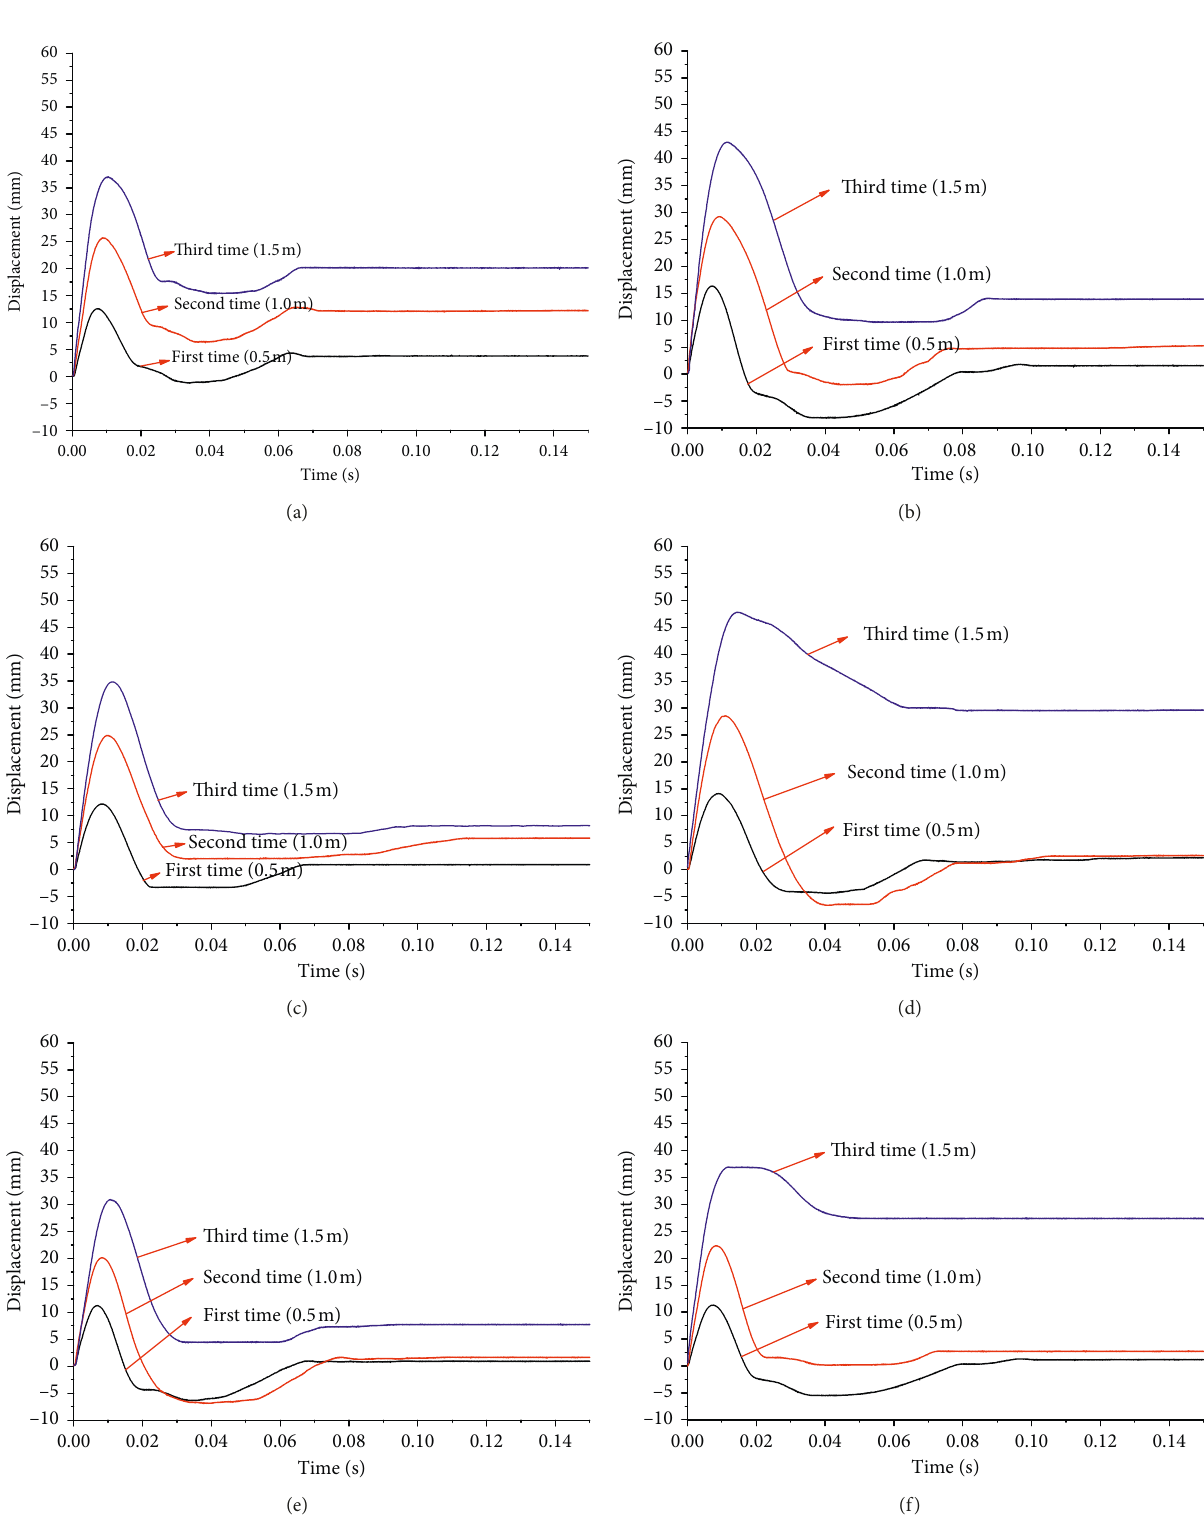
Figure 11: Time history curve of the displacements. Group A (a) L18 and (b) S12. Group B: (c) L20 and (d) S16. Group C: (e) L25 and (f)